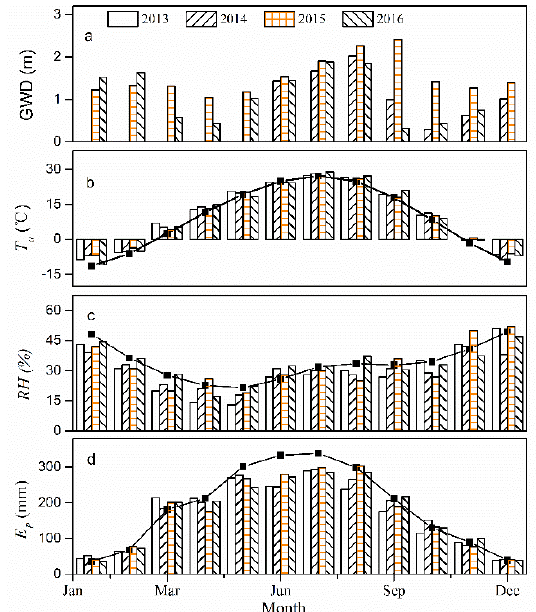
Figure 3. Seasonal patterns of groundwater depth (GWD), air temperature ( T a ), relative humidity ( RH ) and pan evaporation ( E p ) data at the study site. The solid lines indicate the monthly mean values for the period 1957–2016. Table 1. Yearly net ecosystem production (NEP), gross primary production (GPP), ecosystem respiration (Re), and mean GPP/Re in 2013–2016 at the study site. Also shown are mean air temperature ( T a ), annual precipitation ( P ), and groundwater depth (GWD) during the growing season.